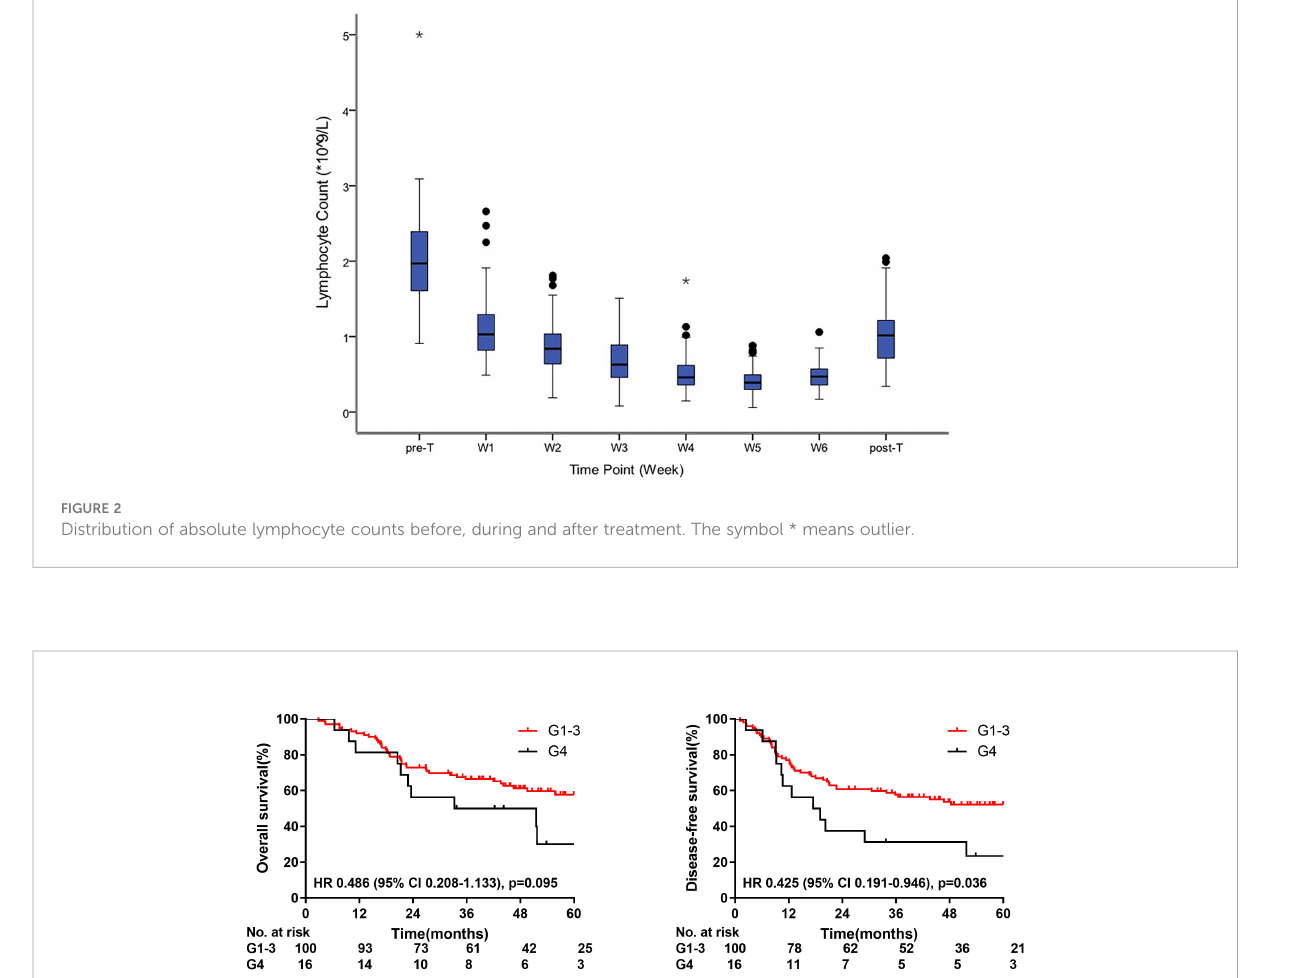
FIGURE 3 Overall survival and disease-free survival for patients with radiation induced